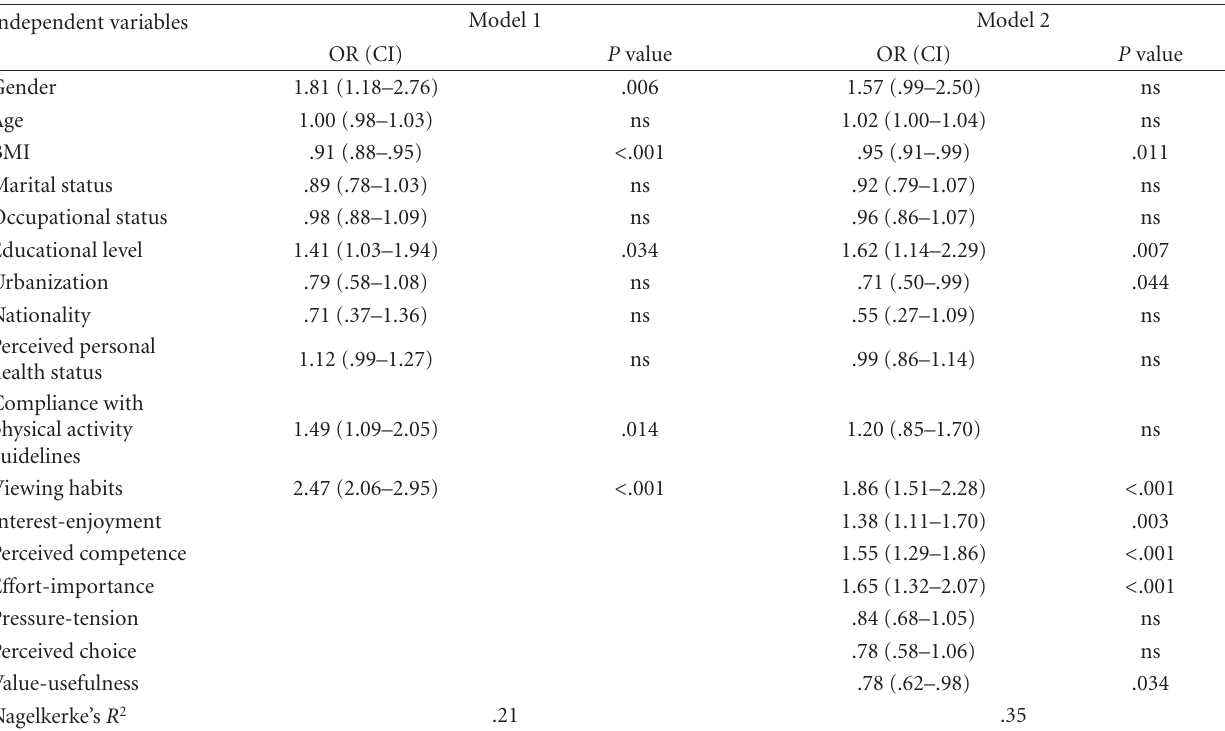
Table 4: Logistic regression analysis of the IMI subscales on participation in the NOM-tv exercises, corrected for background